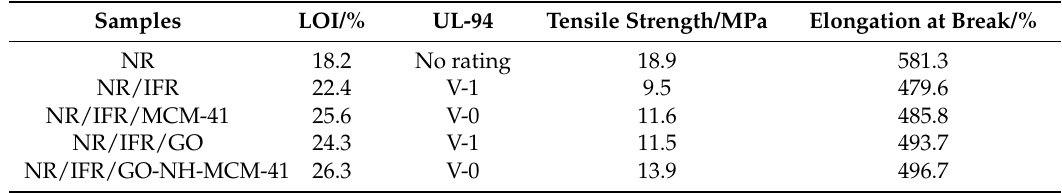
Table 2. Flame retardancy and mechanical properties of flame retardancy natural rubber (FRNR) composites.